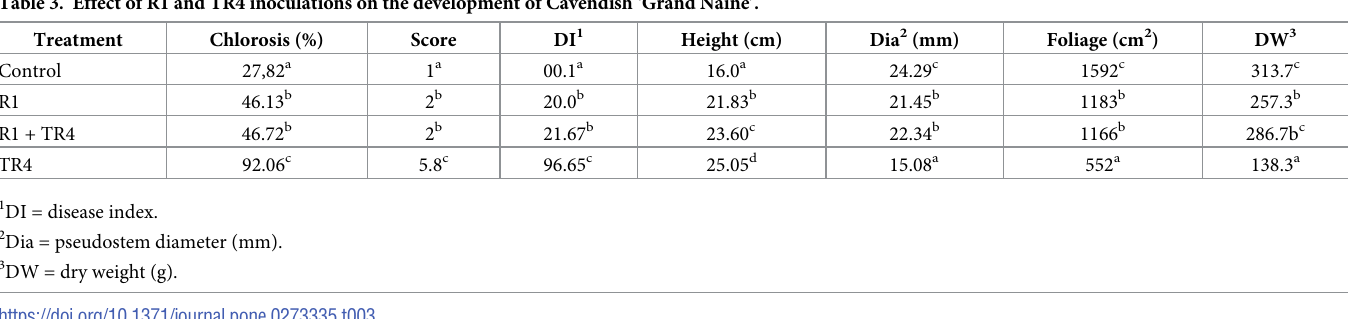
Table 3. Effect of R1 and TR4 inoculations on the development of Cavendish ‘Grand Naine’. Treatment